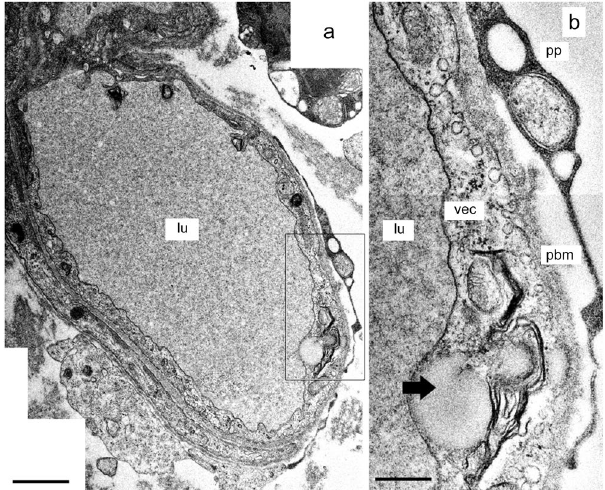
Figure 3. The BLB in Meniere’s disease (39-year-old). Capillary located in the utricle stroma underneath the vestibular sensory epithelia. ( a ) Low magnification view. VECs (vec) show an almost normal appearance, lumen is normal (lu), the extracellular matrix shows edema. ( b ) High magnification view -insert from ( a ). Abundant open caveolar flask-like structures that almost touch the abluminal membrane of the vascular endothelial cell (vec) were observed. The border of the basal membrane (pbm), is almost normal, a pericyte process (pp) is detached. Thick arrowhead points to a large vacuole in the vascular endothelial cell cytoplasm. Bar in